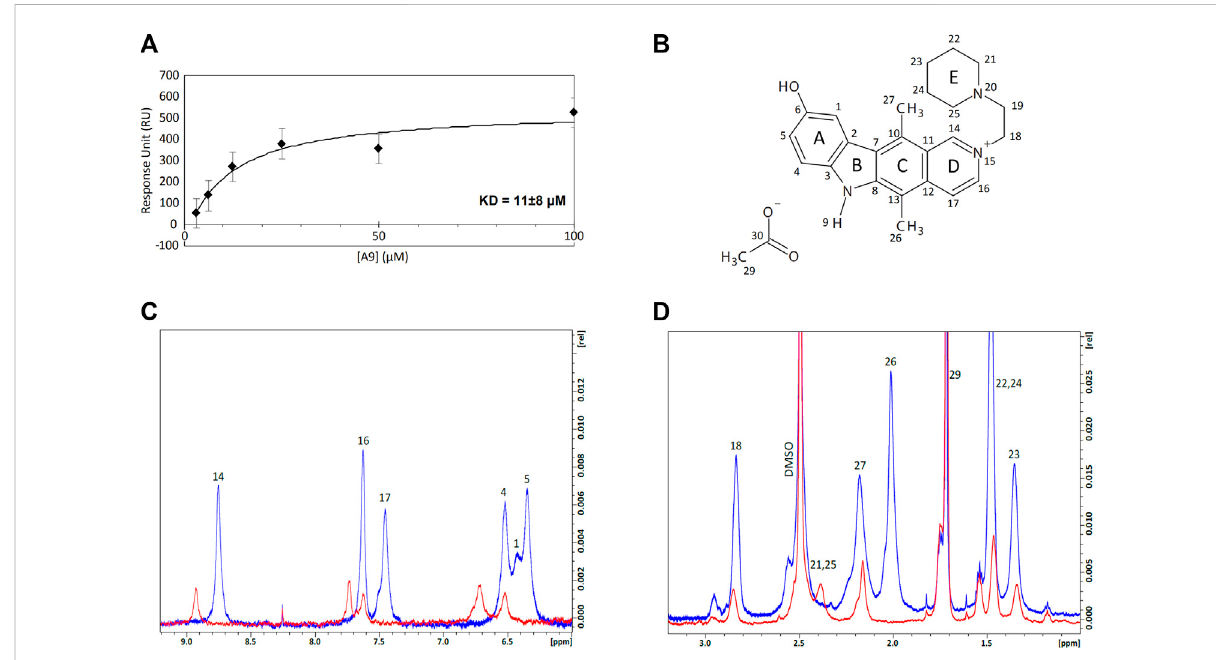
FIGURE 3 Equilibrium af fi nity and binding regions of A9 to heparin. (A) Equilibrium af fi nity of A9 binding to heparin determined by SPR to be 11 μ M. A9 concentrations are 3.125, 6.25, 12.5, 25, 50, and 100 μ M. The black curve represents the best fi t of a steady state af fi nity model (Biacore T200 Evaluation Software v. 3.0). See Supplementary Figure S3 for all FCs. (B) Numbered structure of A9. Chemical namesinclude: 9-hydroxy-2-(2- piperidinylethyl)ellipticinium acetate and 6H-Pyrido[4, 9-hydroxy-5,11-dimethyl-2-[2-(1-piperidinyl)ethyl]-, acetate. Molecular Formula: C24H28N3O.C2H3O2. Molecular Weight: 434.0 g/mol. PubChem SID: 573696. 92764817. (C) Overlay of the 1 H spectra zoomed in to the aromatic regionofA9(6 – 9.2 ppm)byitself(blue)andincomplexwithheparin(red)at100:1 Mratio.Complexformationshowslossof 1 Hsignalandsigni fi cant chemical shift perturbations (CSPs) from A9 ’ s aromatic region in the presence of heparin. (D) Overlay of the 1 H spectra zoomed in to the aliphatic region (1 – 3.2 ppm) of A9 by itself (blue) and in complex with heparin (red) at 100:1 M ratio. Complex formation shows loss of 1 H signal from A9 ’ s aliphatic region in the presence of